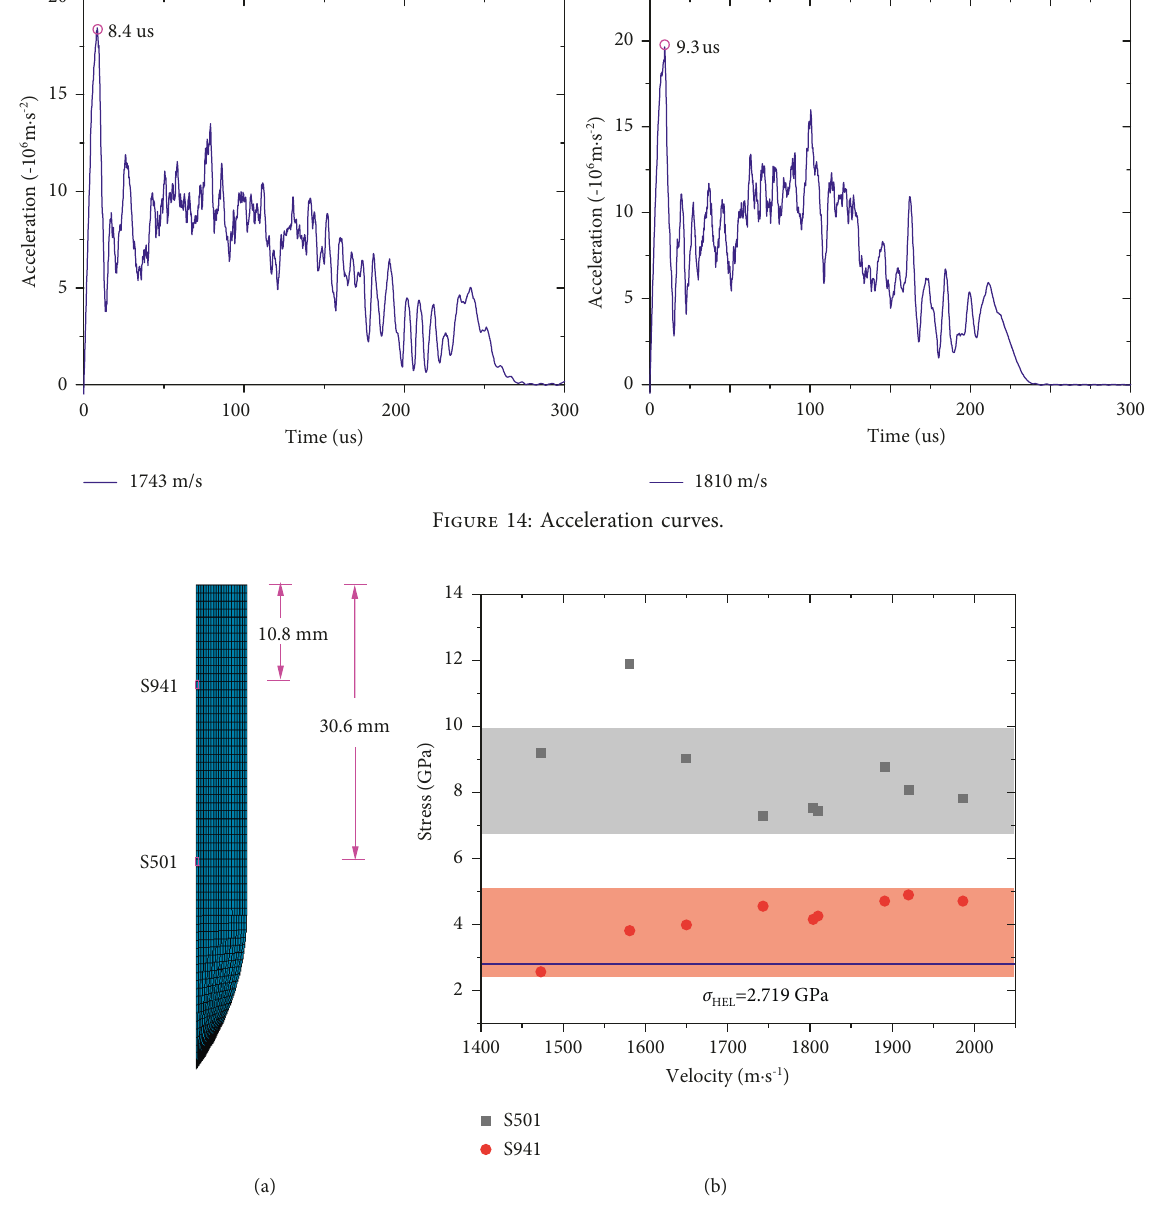
Figure 15: Selected element and maximum stress value. (a) Unit location. (b)